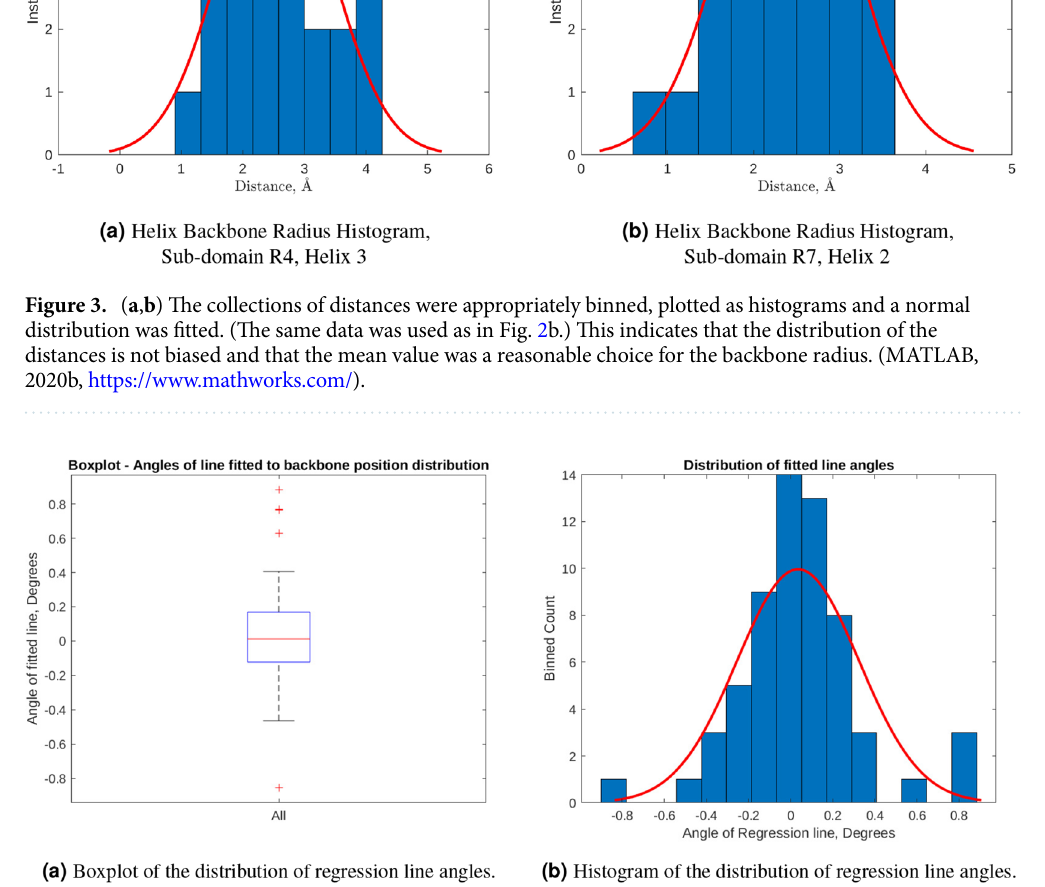
Figure 4. ( a , b ) show that the distribution of differences in angles between the regression lines, which represent the skew of the width of the alpha-helix backbone structure, and the average line, which represents approximated width of the alpha-helix. The difference in angles have a median value of 0.0122 degrees, an mean of 0.0350 degrees and a standard deviation of 0.2906 degrees. ( b ) also shows the the distribution is more specific than a normal distribution and the majority of the angles are near zero. (MATLAB, 2020b, https:// www. mathw orks.